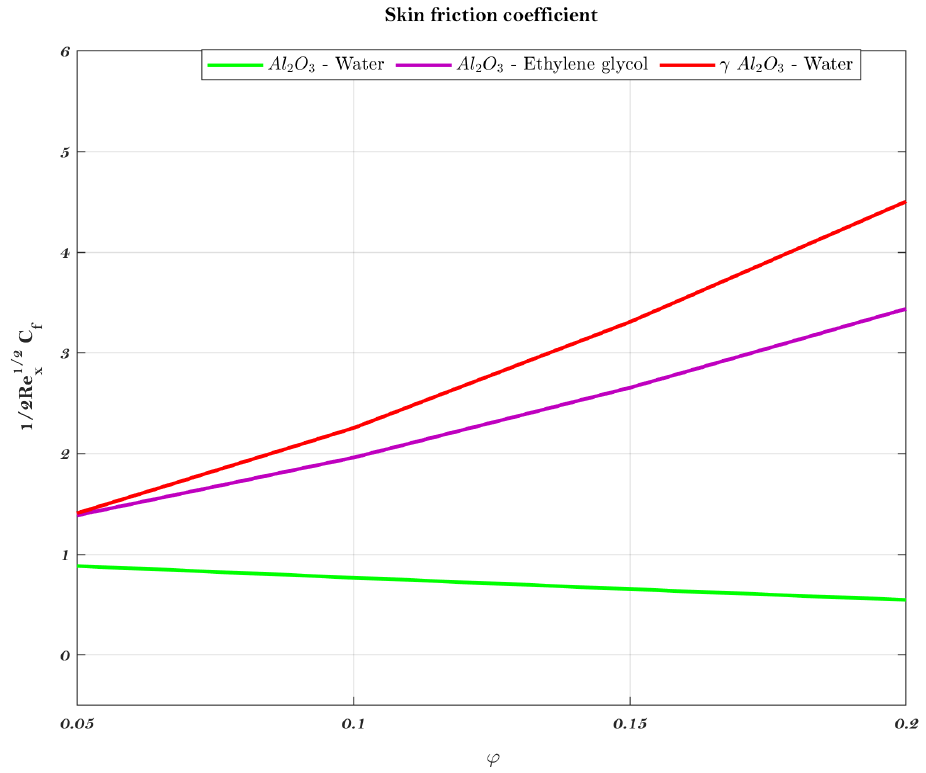
Figure 20. Frictional efficiency of skin as a function of ϕ